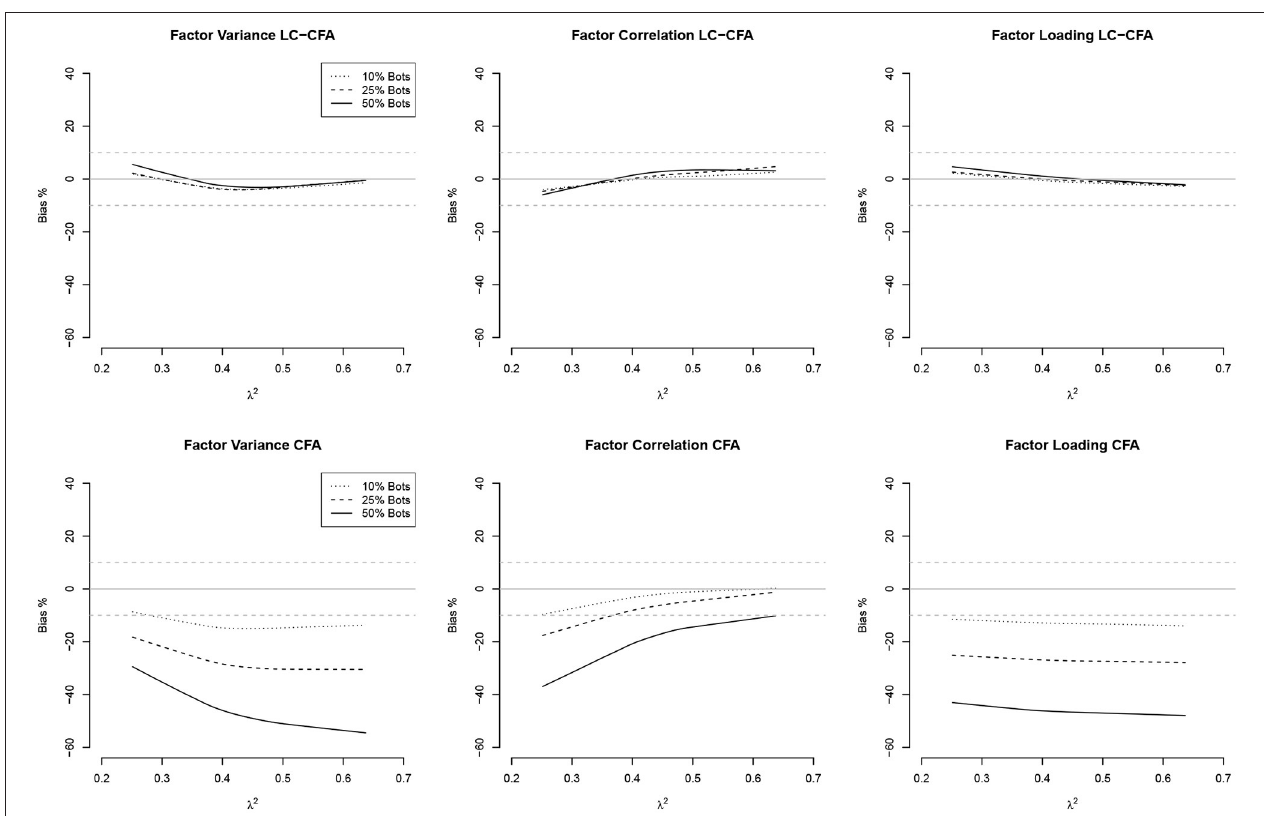
FIGURE 2 | Relationships (loess approximations) between communalities ( λ 2 ) and the bias of factor variances, factor correlations, and factor loadings from the LC-CFA (top) and CFA (bottom) . The bias was averaged across conditions of sample size and model